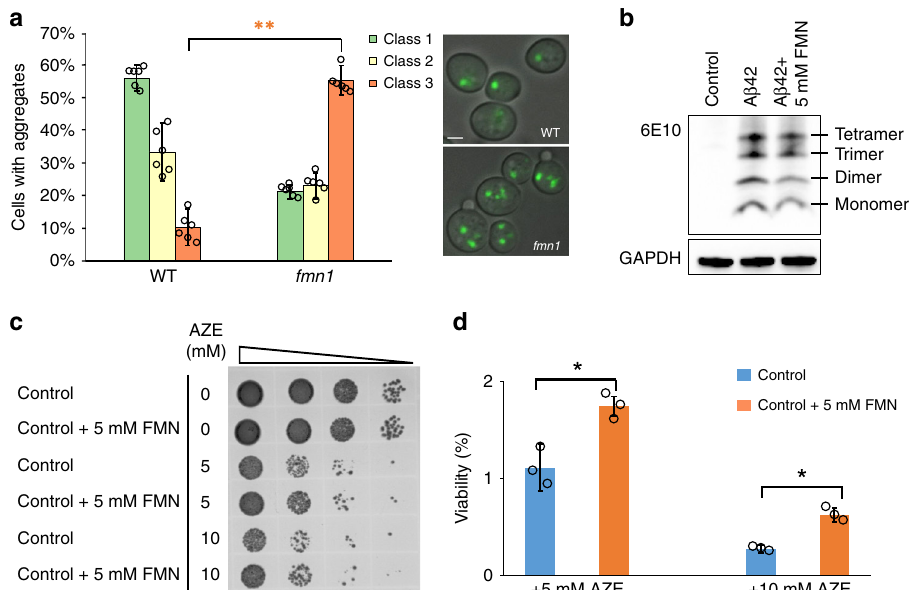
Fig. 4 FMN supplementation facilitates protein folding. a Quanti fi cation of aggregate foci after heat shock for 90 min in wild type and fmn1 mutant yeast cells. Class1: one aggregate per cell (as highlighted by single GFP cluster); Class 2: two aggregates per cell; Class 3: ≥ 3 aggregates per cell. Bar graphs show fractions of Class 1, 2, and 3 cells for each strain. Above 500 cells were measured per sample with results shown as average values ± SD from six biological experiments. Scale = 2 µ m. ** p < 0.001. b Western blot of A β 42 expression from stationary phase cultures, using the 6E10 A β speci fi c antibody. GAPDH was used as the loading control. c Ten-fold serial dilutions of the control strain after 3 h of treatment with 5 or 10 mM L-azetidine-2-carboxylic acid (AZE). d Colony forming unit (CFU) measurement of control strain after 5 mM or 10 mM of AZE treatment as a measurement of viability ( n = 3 ± SD). * p < 0.05. Source data are provided as a Source Data fi le.